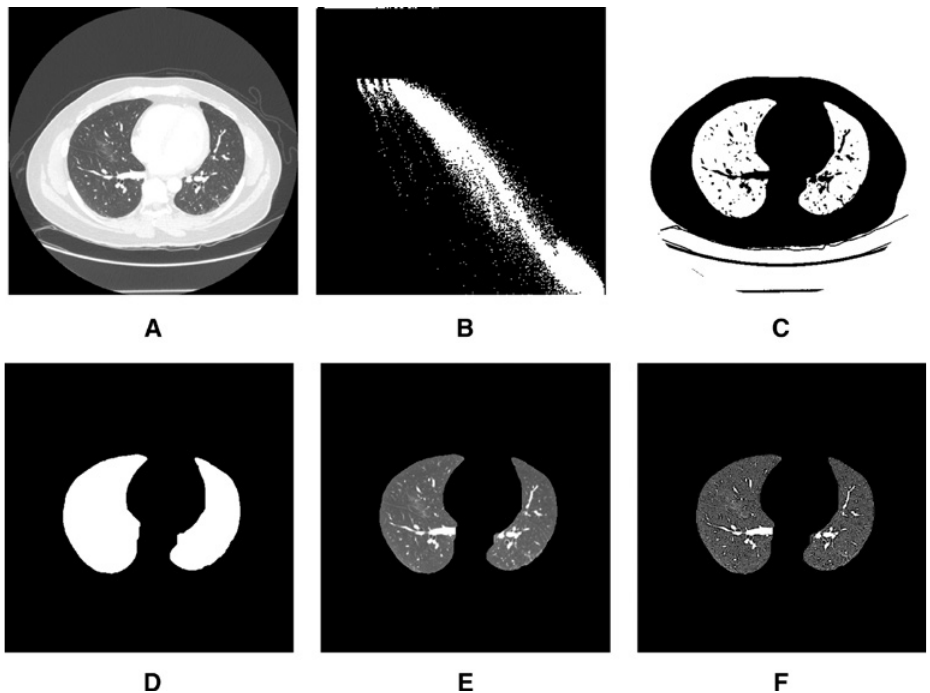
Figure 2: Segmentation of lung parenchyma in thoracic CT image by 2D Otsu. (A) CT slice image 1 (CT-1). (B) 2D histogram. (C) Segmentation done by 2D Otsu. (D) Dilation image. (E) Segmented lung paren- chyma. (F) Enhanced